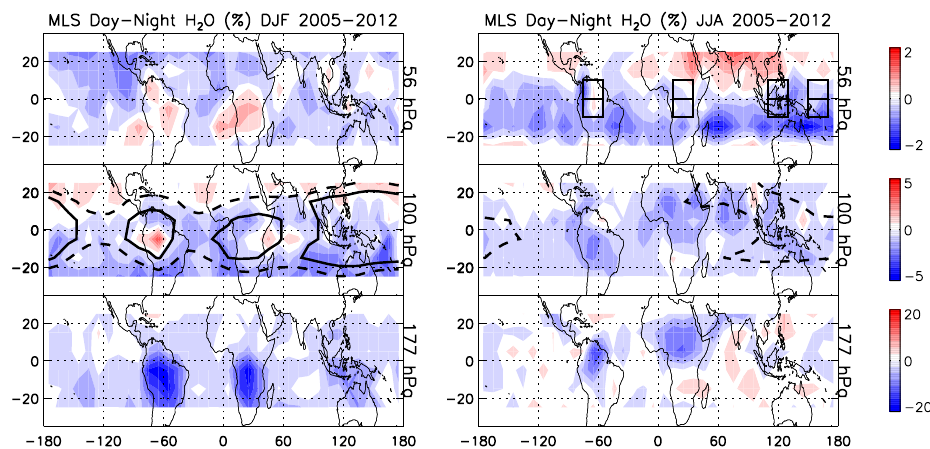
Figure 2. (Left, from top to bottom) Mean relative difference between the daytime (13:30LT) and night-time (01:30LT) MLS H 2 O measure- ments for December, January and February for 8 years (2005–2012) in the 25 ◦ N–25 ◦ S latitude band at 56, 100 and 177hPa. The 192 (black solid line) and 195K (black dashed line) temperature contours are represented at 100hPa. (Right) Same as left but for June, July and August. The eight black boxes at 56hPa represent the eight areas of study; namely, northern and southern tropical America, Africa, the maritime continent and western